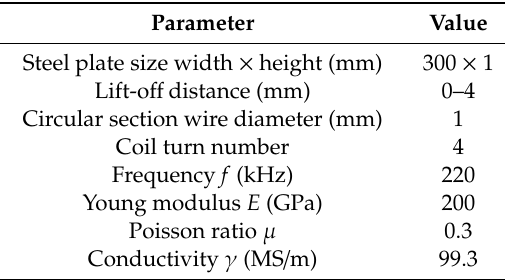
Figure 3. The characteristics of high-energy pulse excitation. ( a ) Current in excitation coil of the high-energy pulse EMAT simulation; ( b ) The spectrum of high-energy pulse EMAT excitation. Table 1. The parameters of the model.